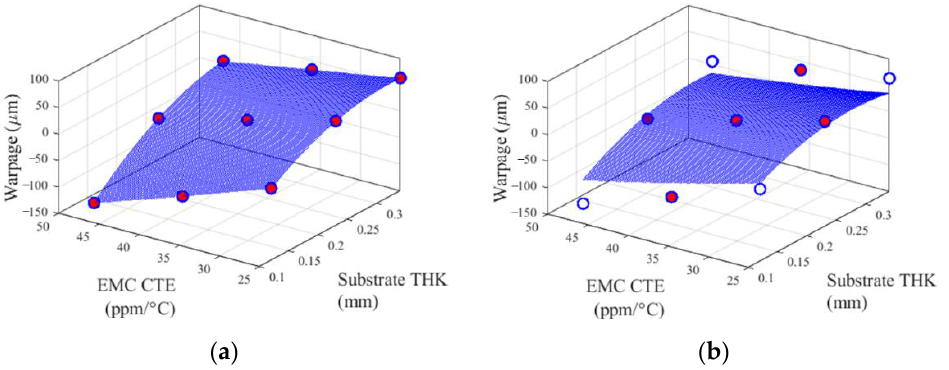
Figure 9. 2D performance functions of design variables of ( a ) Bivariate Cut-HDMR and ( b ) CCD, where design variables other than EMC CTE and substrate thickness are kept at their mean values.